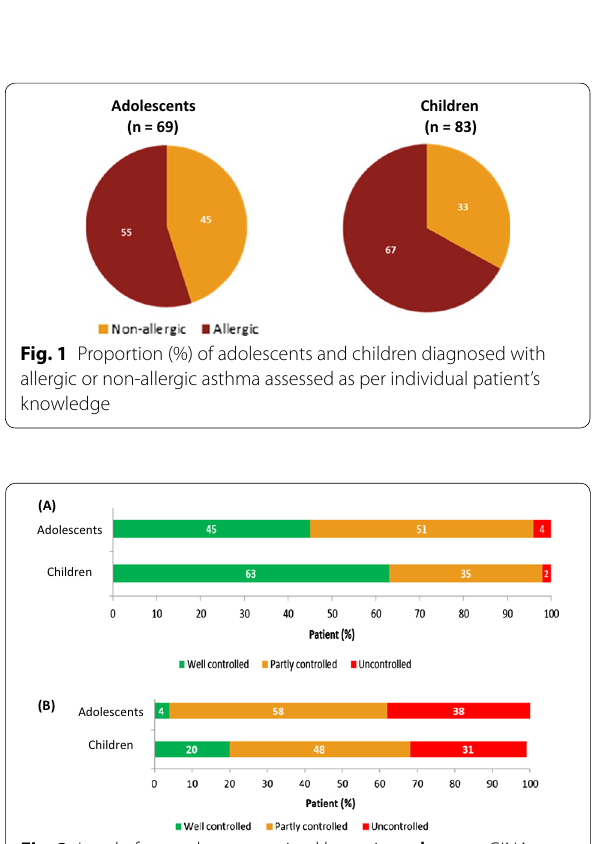
Fig. 2 Level of control a as perceived by patients, b as per GINA control questionnaire